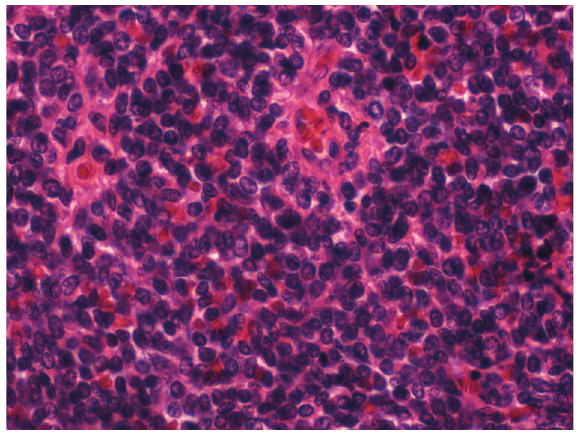
Figure 1: High power H and E image of a monotonous small round blue cell infiltrate.